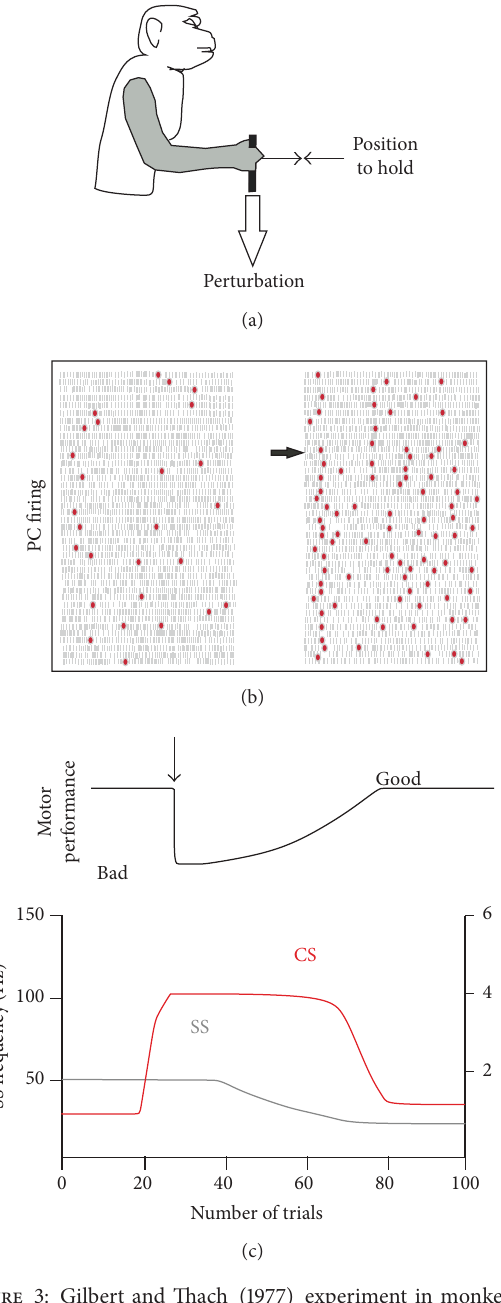
Figure 3: Gilbert and Thach (1977) experiment in monkey. (a) Task consist to control a handle horizontally by flexing or extending the wrist to a central position and to hold it there despite flexor and extensor loads applied to the handle. (b) CS and SS frequencies change for a PC after a change in load (horizontal arrow). Each grey bar represents an SS and the red dots a CS. Each row of bars represents the discharge during a trial successively represented from top to bottom. Each flexor trace on the left, for which the monkey performance was good, is followed by an extensor trace on the right. At the arrow, the known extensor load of 300g was modified to a novel 450 g inducing a strong decrease in the performance. (c) Idealized representation of the SS and CS firing a long time and the number of trials before load perturbation (vertical arrow), during the transition period from bad to good performance, and after. ( Adapted from [36, 98] with permission